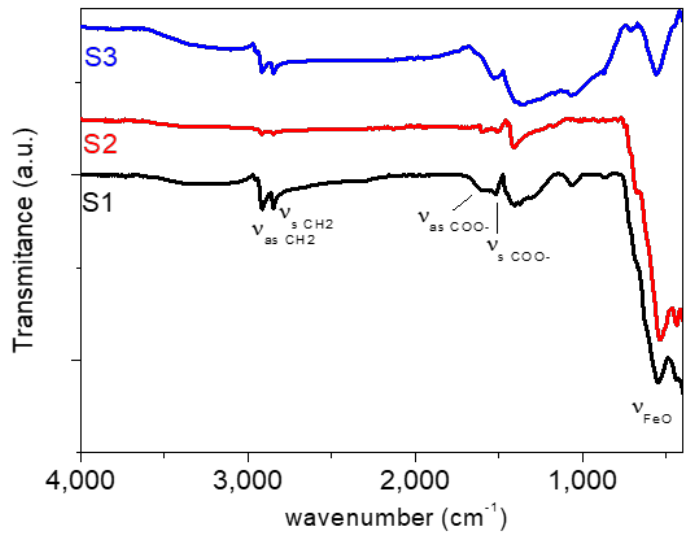
Figure 2. Fourier transform infrared spectroscopy (FT-IR) spectra of coated Fe 3 O 4 nanoparticles: (S1)